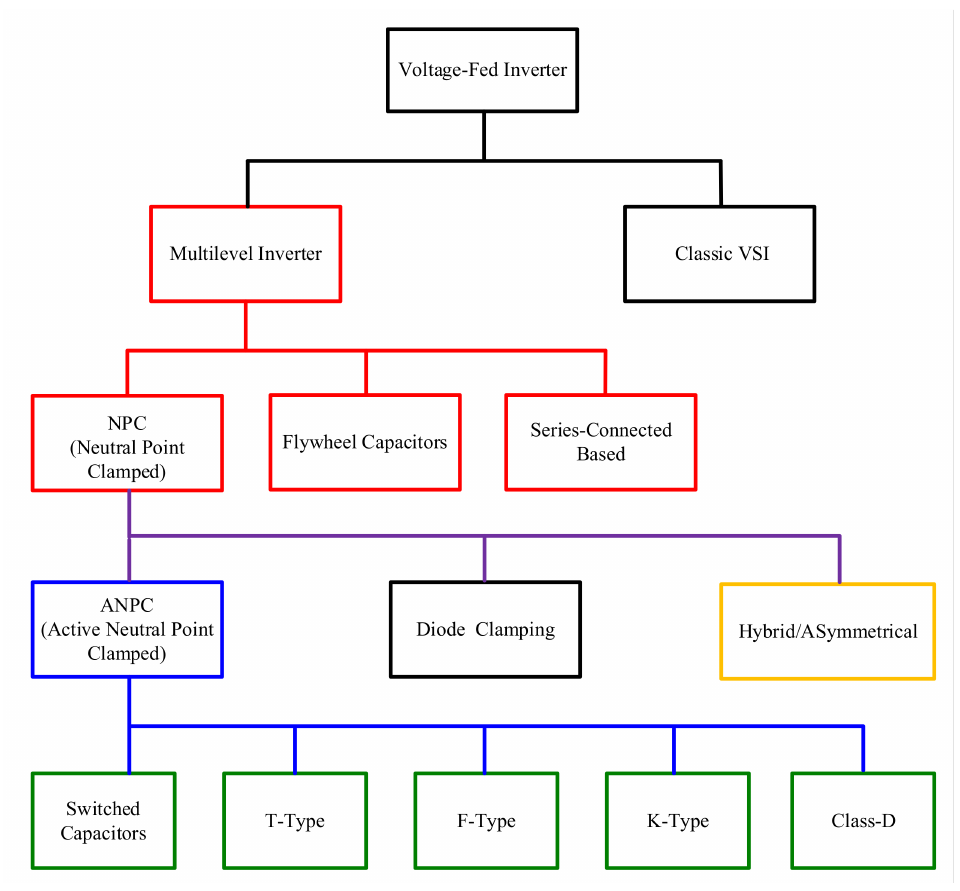
Figure 1. Voltage-fed DC-AC inverter